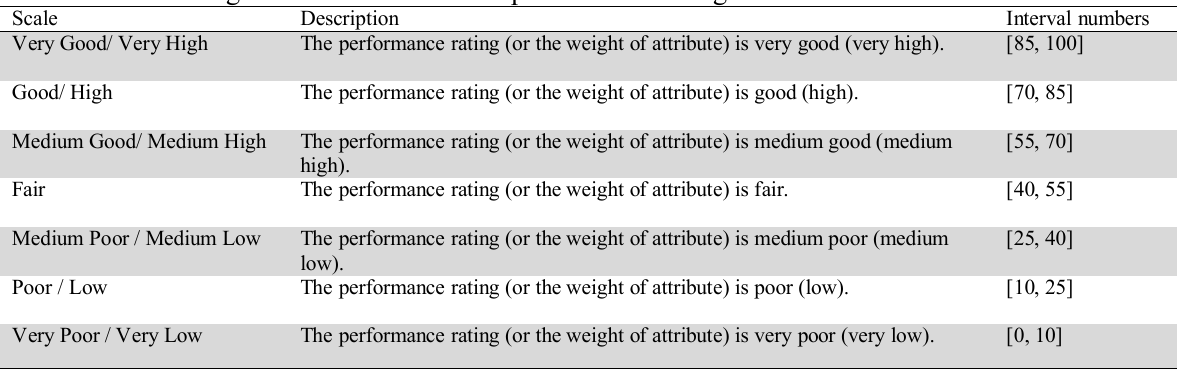
7–scale for the weights of attributes and the performance